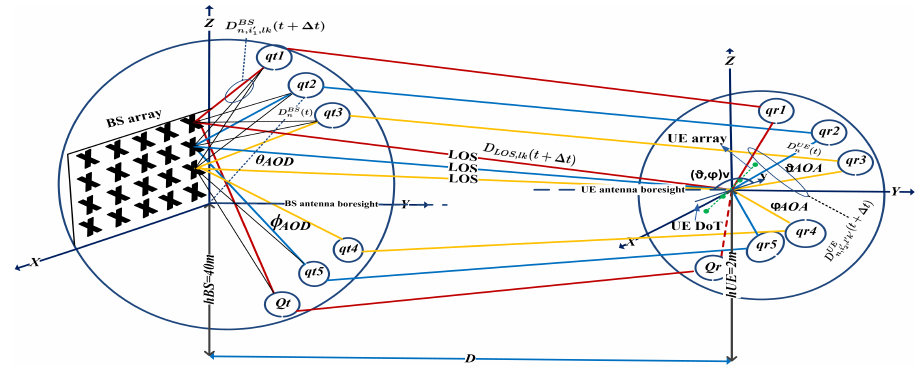
Figure 2. A more detailed of field experiments of the beam pattern using spherical coordinate system for non-stationary massive MIMO